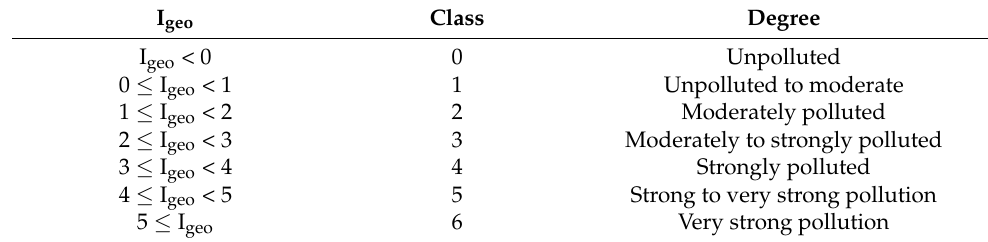
Table 3. Contamination Degree Based on Geo-Accumulation (Igeo) Values.